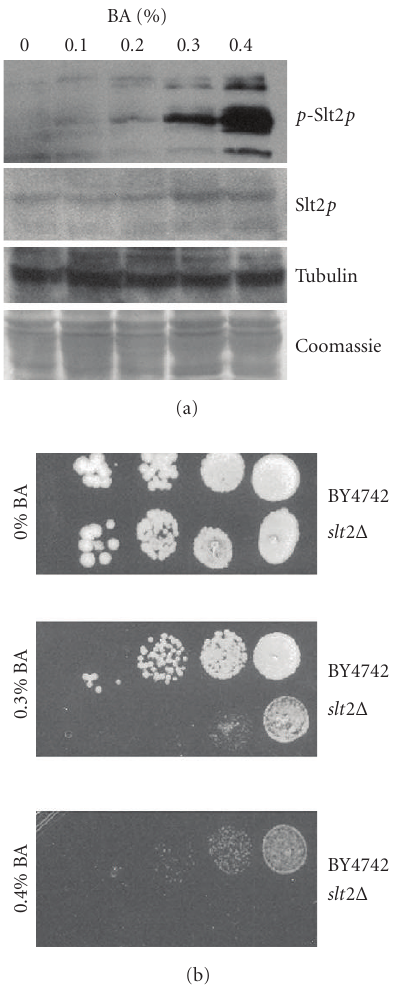
Figure 6: Slt2p-signaling in BA-treated cells. (a) Detection of phosphorylated Slt2p by western blotting in strain YPH499. Phosphorylation of Slt2p increases with escalating concentrations of BA. The total amount of Slt2p increases only slightly under the same condition. Gamma tubulin (Tub4p) detection by western blotting and the Coomassie blue-stained membrane are shown as loading controls. (b) BA sensitivity of an slt2 mutant strain compared to its WT BY4742 as determined by a spot assay.